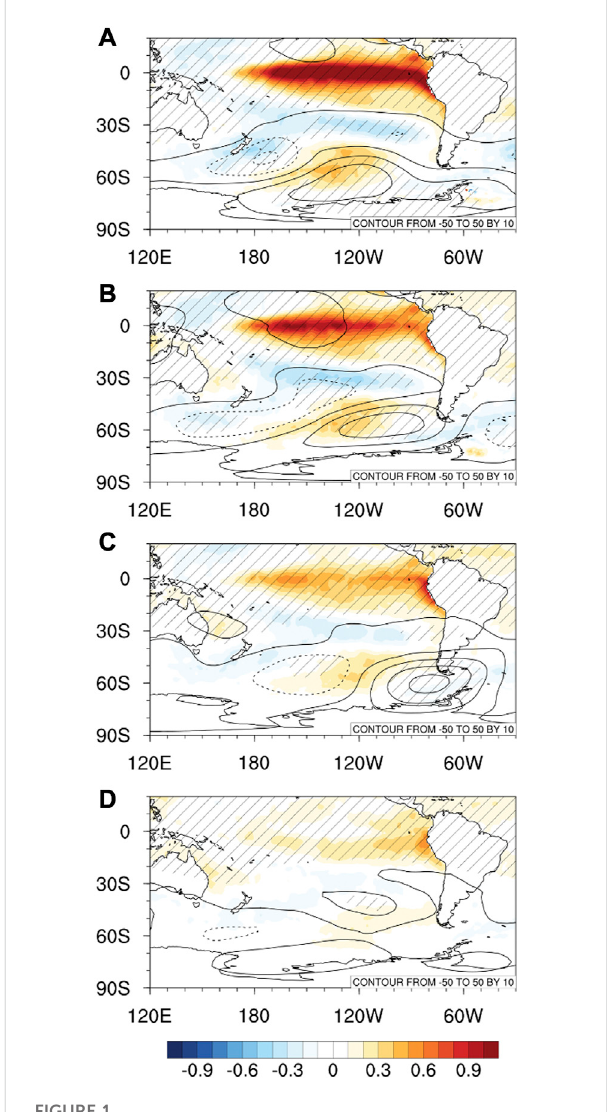
FIGURE 1 Regression maps of the SST (shaded; K) and 500-hPa geopotential height (contour; intervals of 10 m) anomalies for (A) DJ, (B) FM, (C) AM and (D) JJ. The statistically signi fi cant values of the SST and geopotential height anomalies at 95% con fi dence level are represented by shaded and hatched areas,